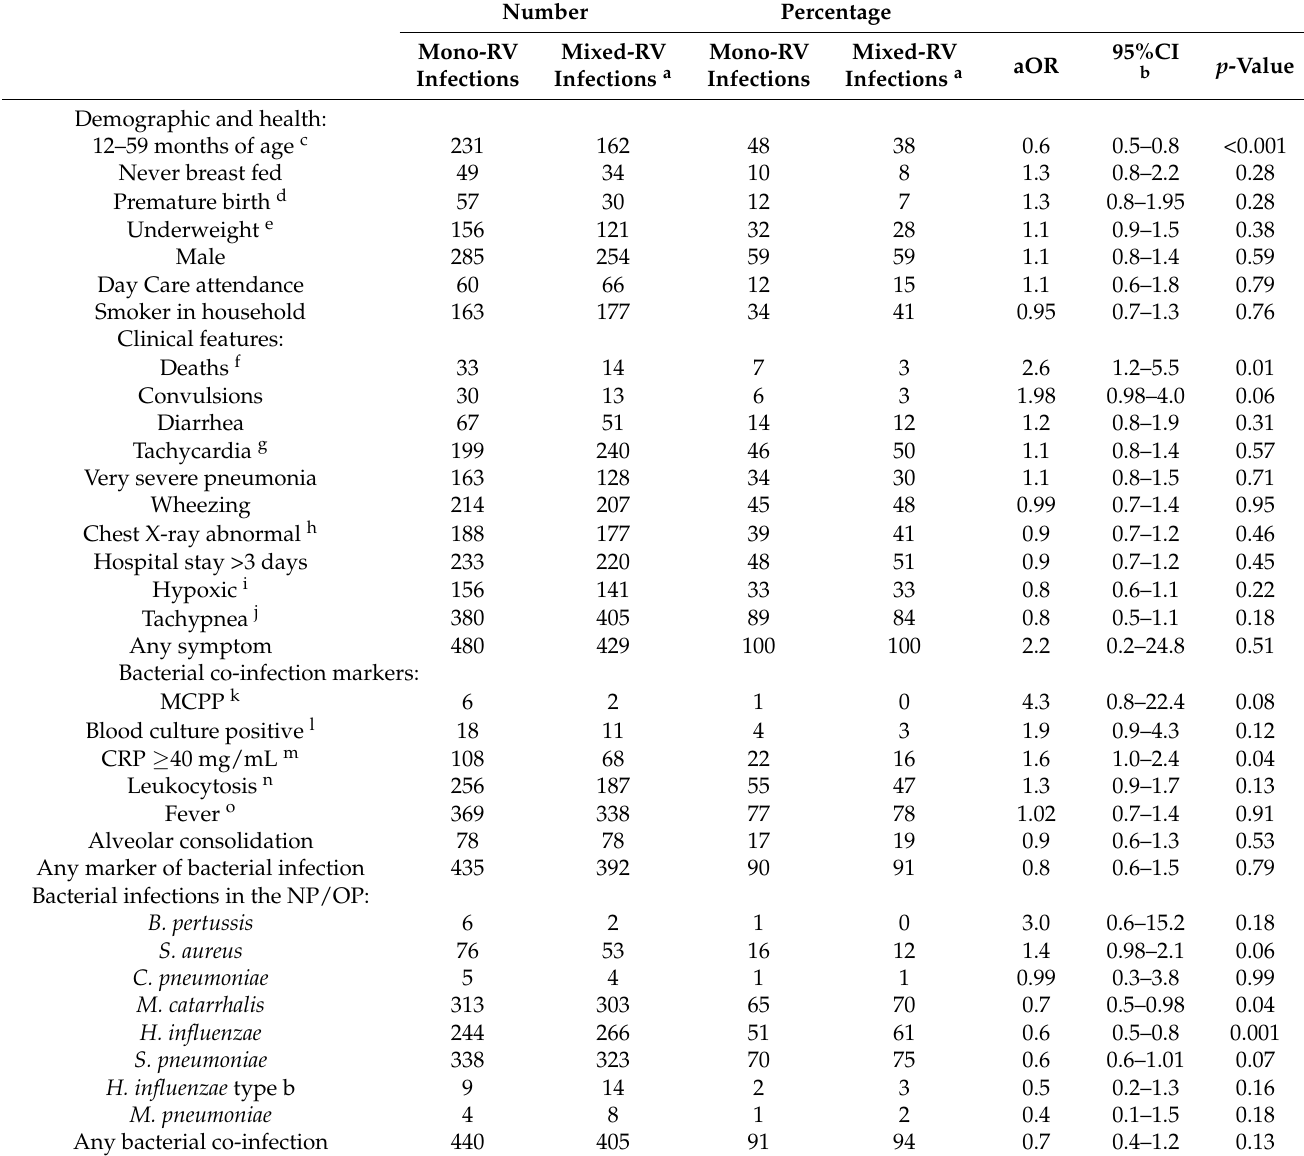
Table 4. Demographics and Clinical Characteristics of Severe and Very-Severe Pneumonia Hospitalized Cases With rhinovirus As the Only Detected Virus (Mono-RV; N = 481) and Those With rhinovirus Plus at Least One Other Respiratory Virus Detected (Mixed-RV; N =